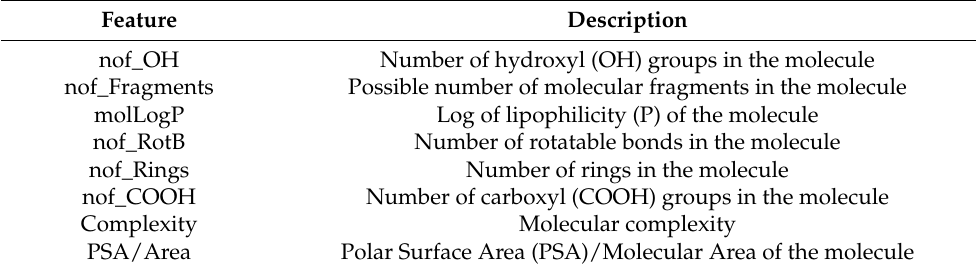
Table 1. Final set of eight features chosen for machine learning